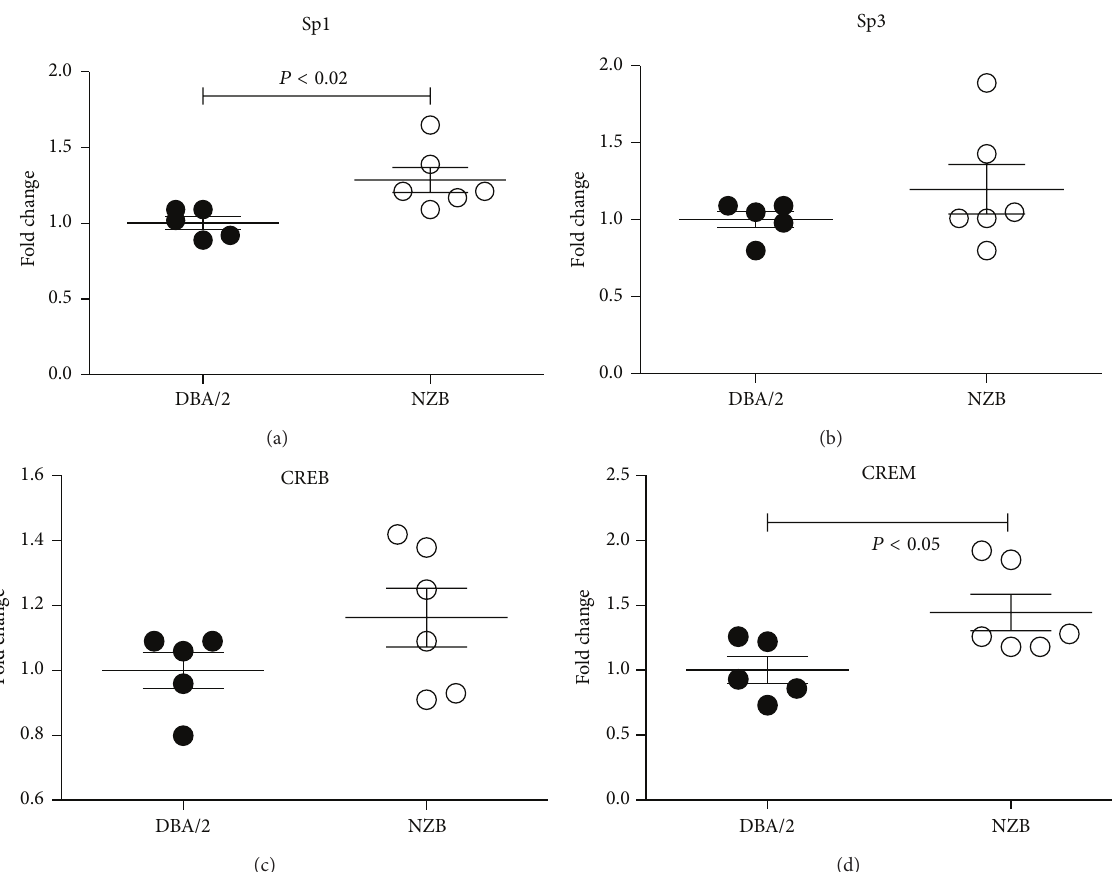
Figure 7: Daf1 transcription factor expression is not reduced in autoimmune prone mice Real time PCR was used to determine Sp1, Sp3, CREB, and CREM mRNA in spleen cells of na¨ıve female autoimmune prone NZB and healthy DBA/2 mice. mRNA levels were determined by the ΔΔ CT method and normalized against cyclophilin A. Data are expressed as fold change compared to mRNA levels measured in DBA/2 samples. 𝑁 = 5 DBA/2 and 6